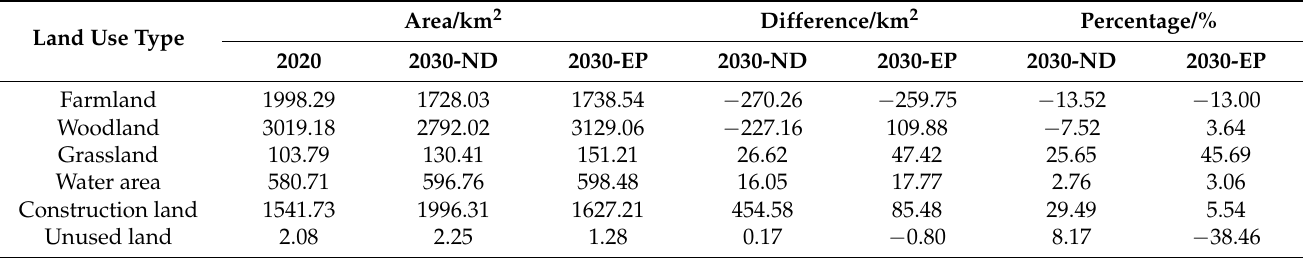
Figure 4. Land ecological security pattern in Guangzhou: ( a ) LESI; ( b ) ecological zoning. Table 4. Land use change in the ND and EP